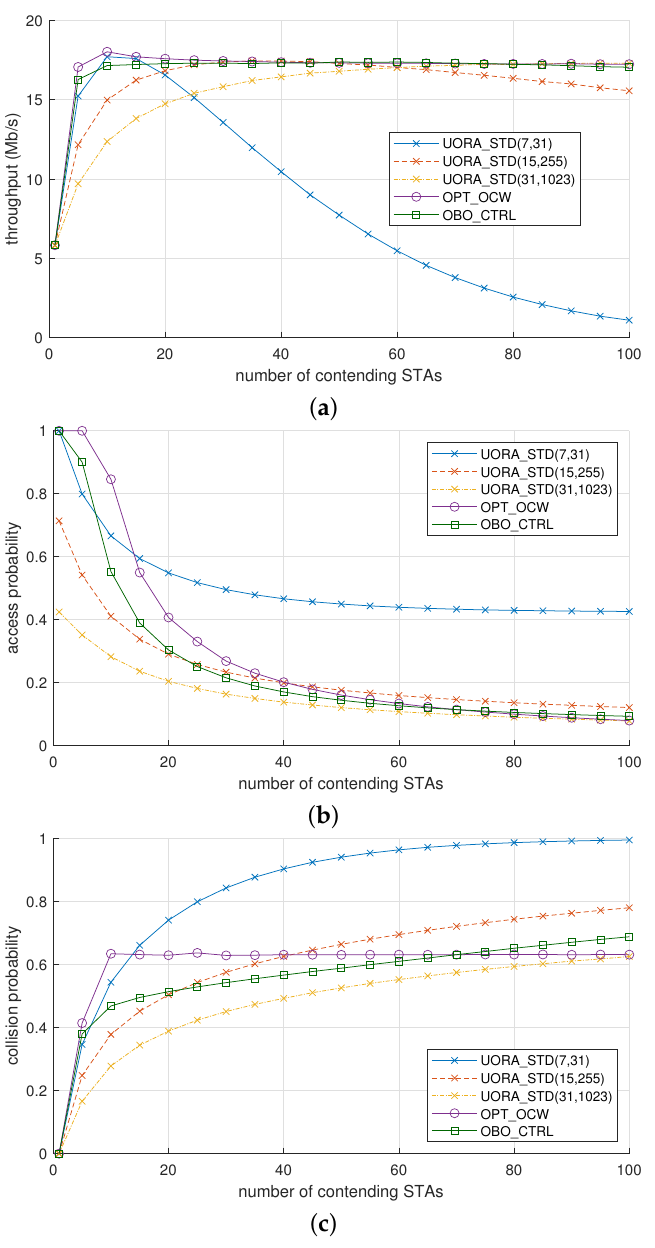
Figure 3. Performance comparison of the UORA schemes: ( a ) throughput, ( b ) access probability, and ( c ) collision